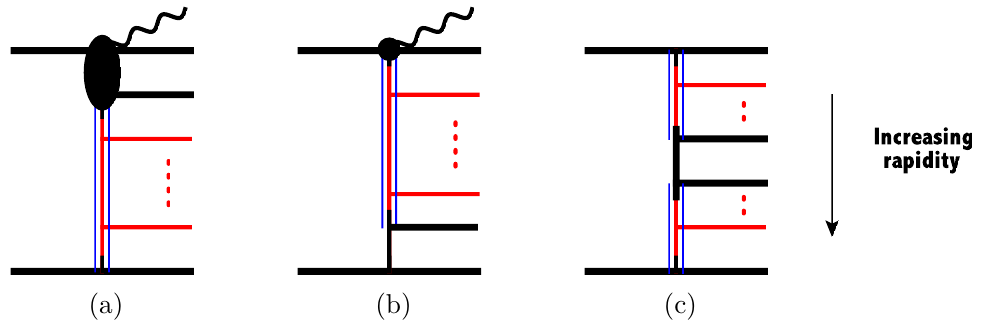
Figure 8. These diagrams illustrate the resummation structure of the new processes we describe after the calculation of the new components in this section: (a) qQ → ( W → ) ‘ ¯ ‘gq 0 . . . Q , (b) ¯ qQ → ( W → ) ‘ ‘q 0 . . . Qg and (c) qQ → q . . . ˜ q ¯˜ q . . . Q . The thick black lines show the components described by the skeleton function B and the external red lines indicate possible real gluons. The blue lines show the region where strong ordering and therefore resummation is applied. The decay products of the W have been omitted for